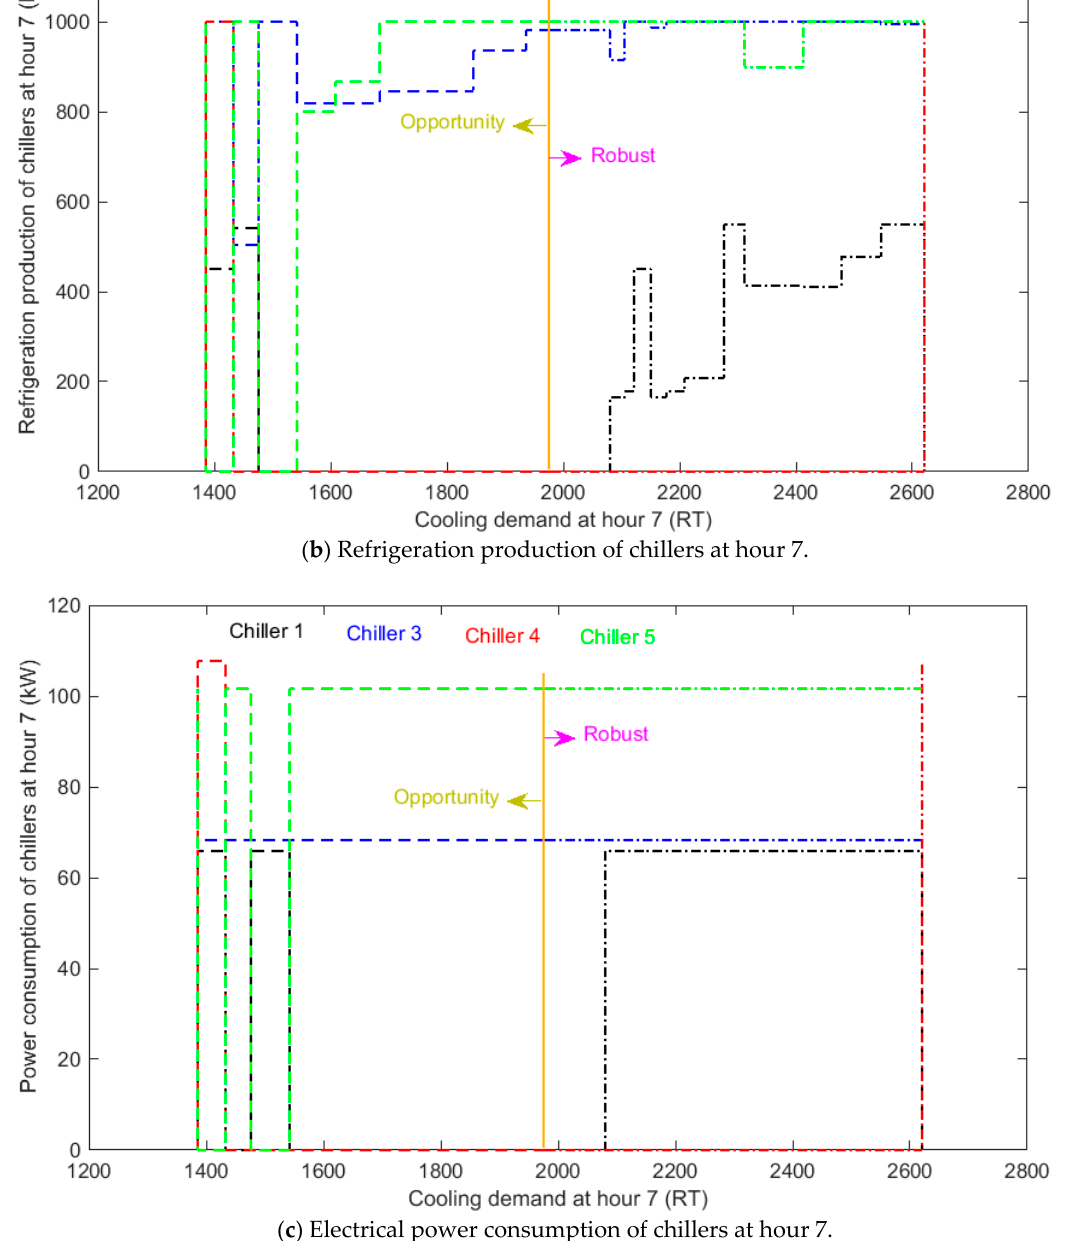
Figure 8. The optimal operating points of the chillers at hour 7 ( a ) PLR, ( b ) cooling generation and ( c ) power